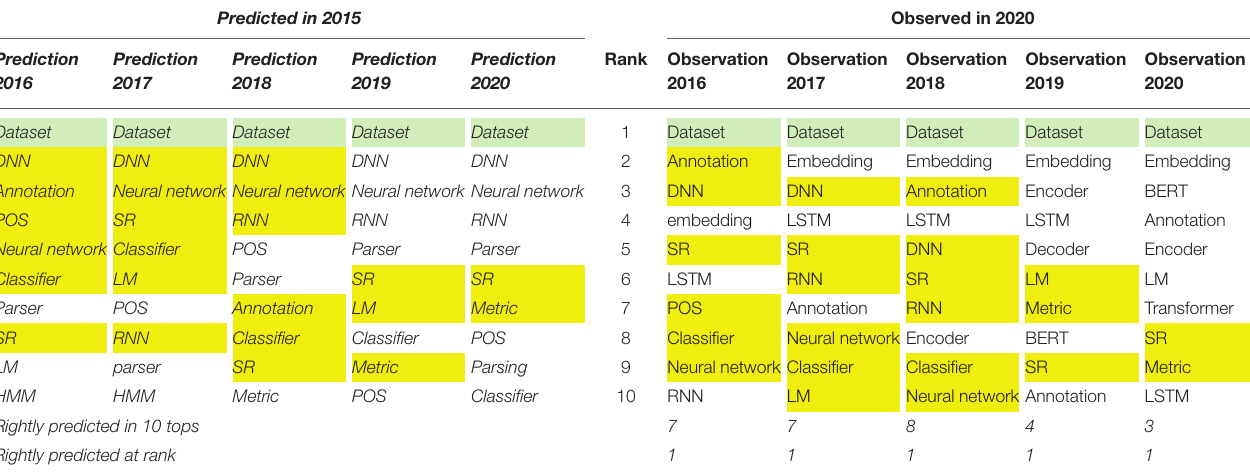
TABLE 23 | Comparison of the terms predicted in 2015 for the next 5 years (2016–2020) with the actual observations on these years (Predictions are in italics. Terms correctly predicted to appear among the 10 top terms are marked in yellow, term correctly predicted at its rank is marked in